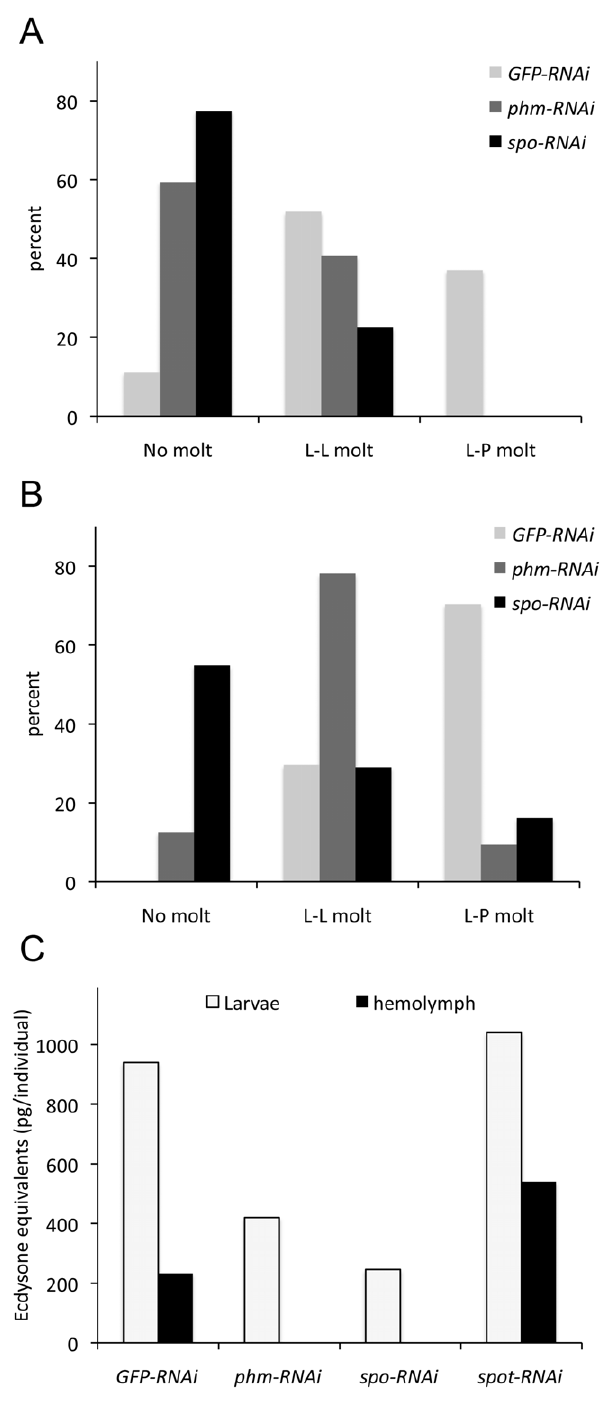
Figure 2. Knock down of phm and spo delays development and reduces ecdysteroid levels in Tribolium . Number of larvae that have undergone a molt after knock down of phm ( phm - RNAi ) and spo ( spo - RNAi ) expression 5 days (A) and 9 days (B) after injection with dsRNA. GFP dsRNA ( GFP-RNAi ) was used as a negative control. (C) Ecdysteroid levels in spo-RNAi and phm-RNAi larvae are reduced compared to the GFP control and to spot-RNAi 5 days after injection with dsRNA. Hemolymph ecdysteroid levels were below the limit of RIA detection (about 10 pg) in the hemolymph of spo-RNAi and phm-RNAi animals. L-L; larval-larval molt, L-P; larval-pupal molt.